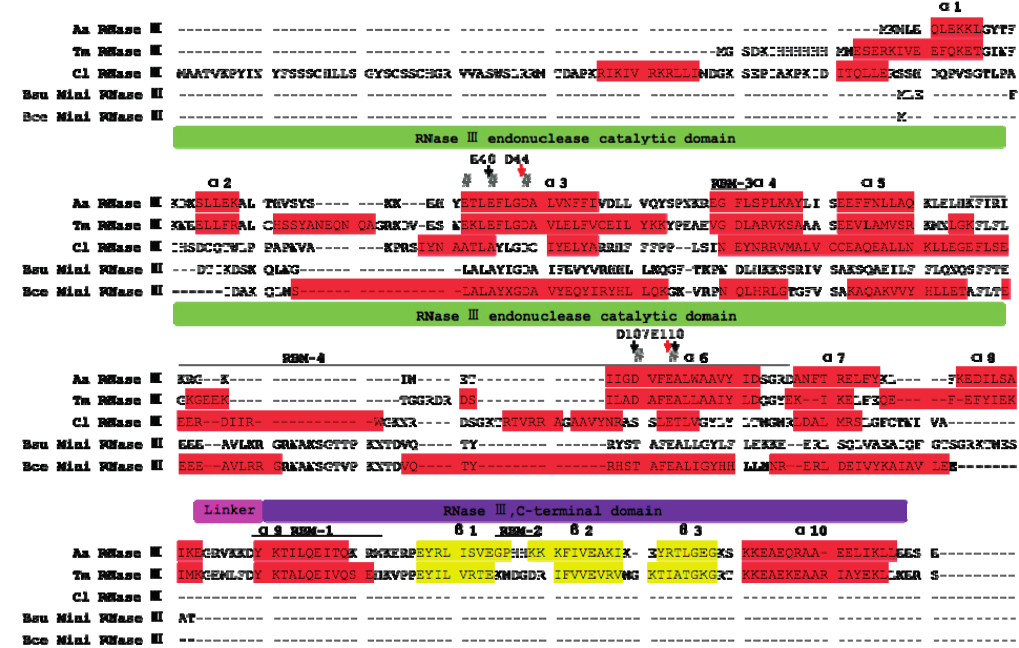
Figure 5. Alignment of the deduced amino acid sequence of Cl RTL1 with four bacterial RNase III proteins. Amino acids corresponding to A. aeolicus (Aa) RNase III (PROTEIN DATA BANK 2NUE), T. maritima (Tm) RNase III (PROTEIN DATA BANK 10OW), B. cereus (Bce) mini-RNase III (PROTEIN DATA BANK 1U61), and B. subtilis (Bsu) mini-RNase III (SWISS-PRO C69742) are aligned with Cl RTL1 . The secondary